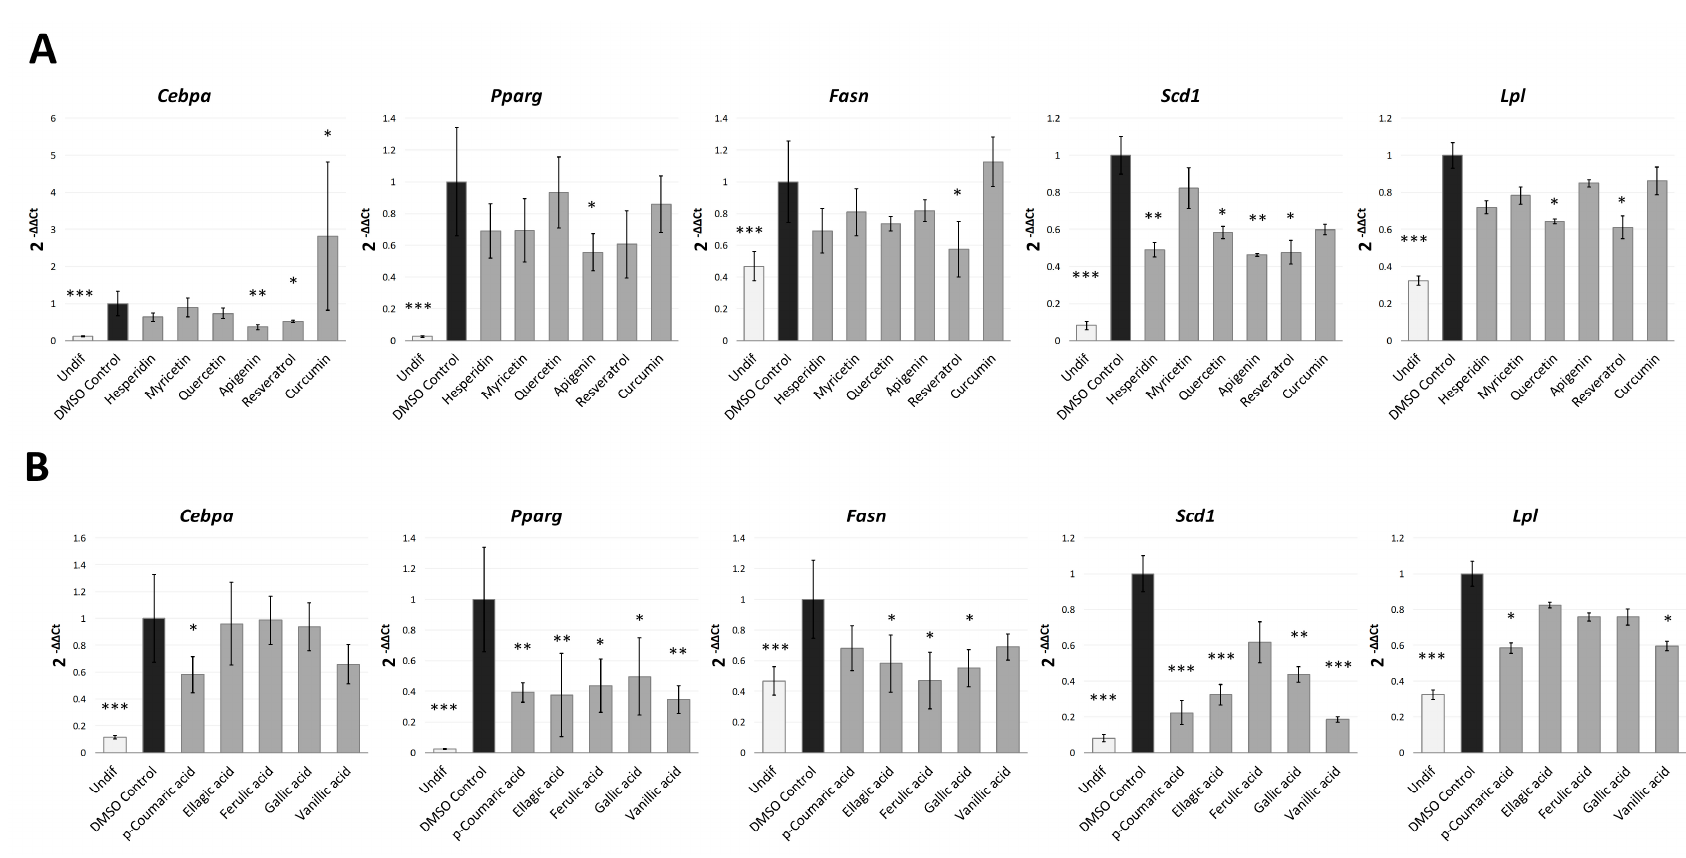
Figure 4. Gene expression analysis of adipogenesis-related genes after treatment (20 µM) with the different polyphenols ( A ) and phenolic acids ( B ) in the S1 analysis (cells collected on day 8). Results are expressed as the fold-difference expression levels of each gene in the treated group compared with the DMSO-control cells, calculated with the 2 −∆∆ Ct method. Significance refers to the effect of each treatment with respect to DMSO-control cells (* p < 0.05; ** p < 0.01; *** p < 0.001).